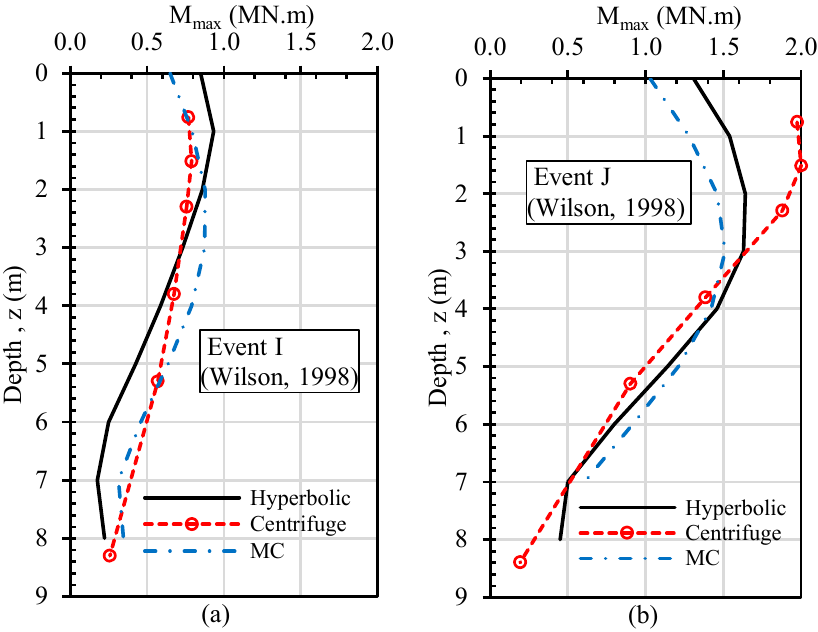
Figure 11. Bending moment variation with depth for verification analyses (Case 2): ( a ) Event I [31] and ( b ) Event J [31].